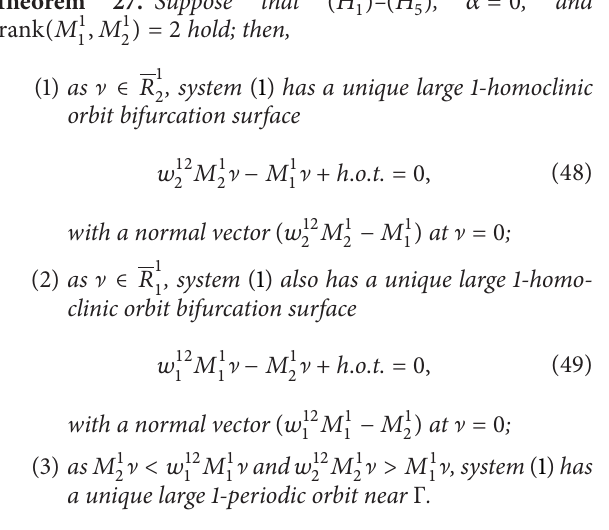
𝐿 (𝑠 ) lies under the curve 𝑁 2 2